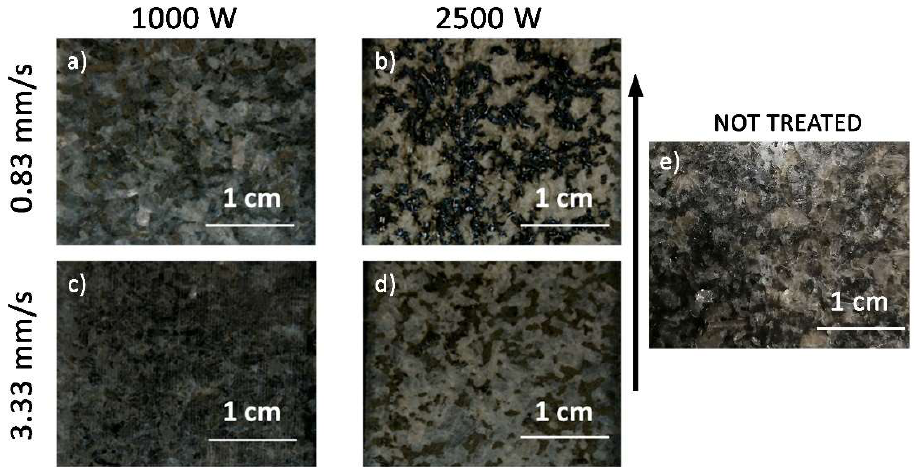
Figure 3. Images showing the aspect of the treated black granite as a function of the laser power and the transverse speed ( a – d ). The black arrow indicates the direction of the “fast” scan speed. ( e ) Image of not treated granite surface.